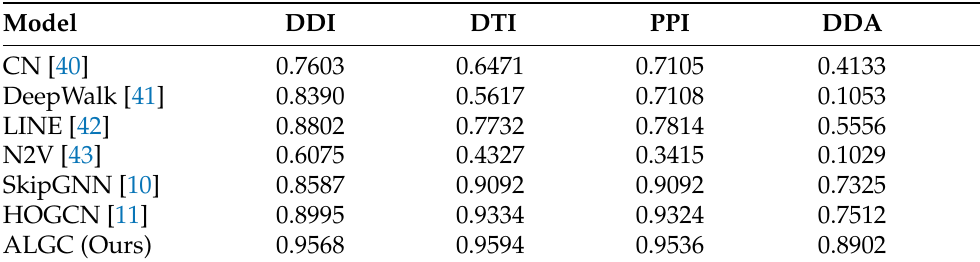
Table 3. Comparison with baselines on training percentages (70%)